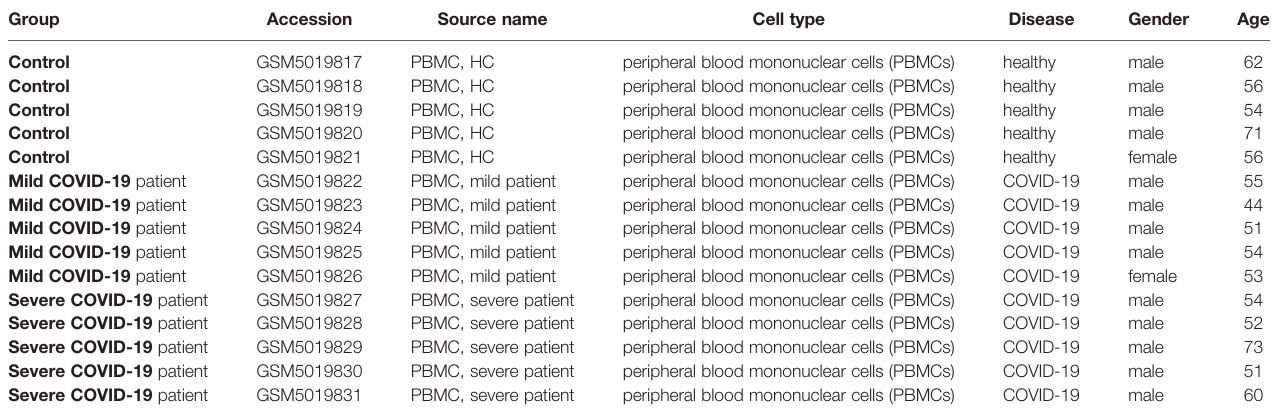
TABLE 1 | The summary of 15 human subjects (control and COVID-19 patients) datasets and study characteristics. Group